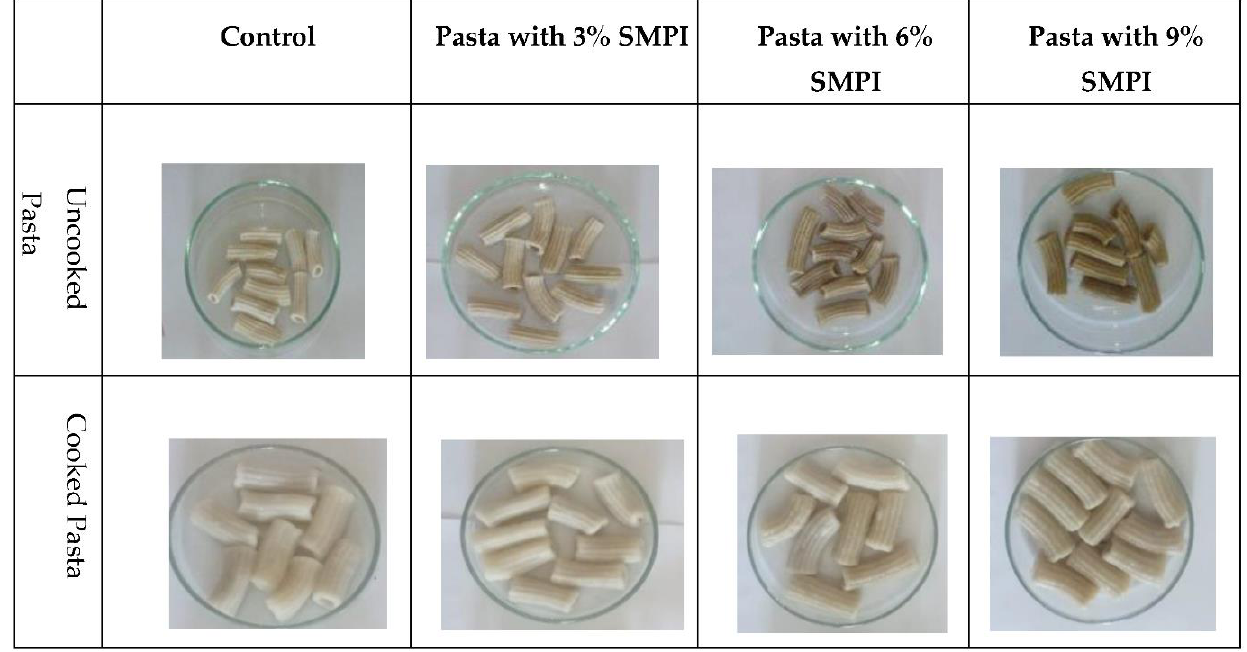
Figure 2. Different pasta samples supplemented with 3, 6, and 9% SMPI.